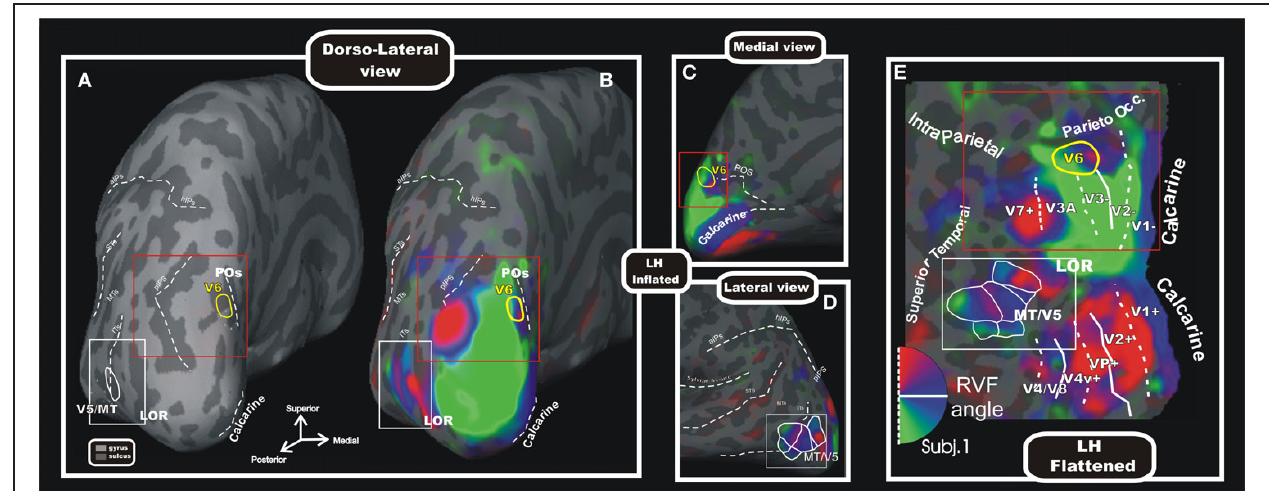
FIGURE 5 | Wide field retinotopy of polar angle representation of area V6 and MT/V5 in the human brain. Inflated (A–D) and flattened (E) reconstructions of the left hemisphere (LH) of one participant are shown [modified from Pitzalis et al. (2006)]. Red and white boxes indicate trough the different views of the cortex the same parts of the brain where areas V6 and V5/MT are respectively located. Inflated cortex is shown in dorso-lateral view (A,B) , and on medial (C) and lateral (D) close-ups views of the posterior brain. (A) Reference image to show the typical position of areas V6 and MT/V5 respect to the medial sulci (POs, calcarine), the pIPS and the lateral middle temporal sulci (ITs, MTs, and STs). The cortical surfaces were defined at the gray-white matter border and have been inflated to reveal regions within the sulci (concavities, dark gray) as well as on the gyri (convexities, light gray). (E) Flattened map shows retinotopic phase-encoded signal in the dorsal and ventral cortical areas (including medial V6 and lateral MT/V5). The boundaries of all visual areas were defined by mapping visual field sign (Sereno et al., 1994, 1995). Dotted